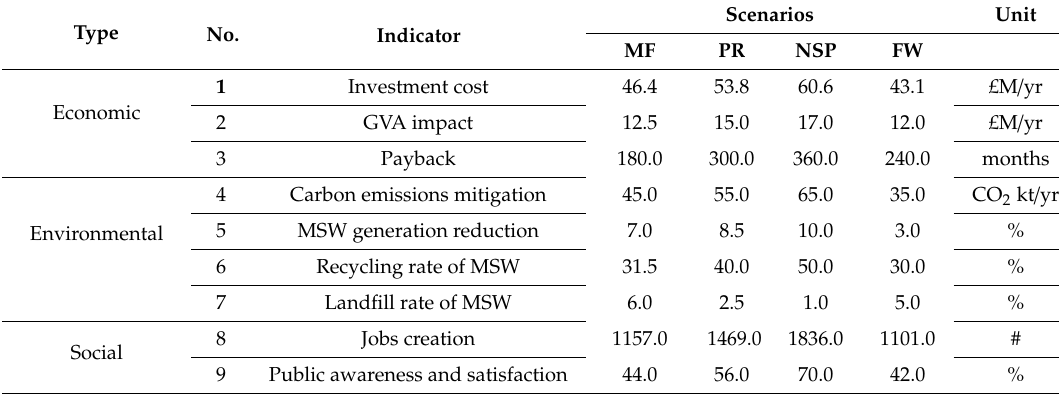
Future CE scenarios matrix for Municipal Solid Waste Management (MSWM) in Birmingham,